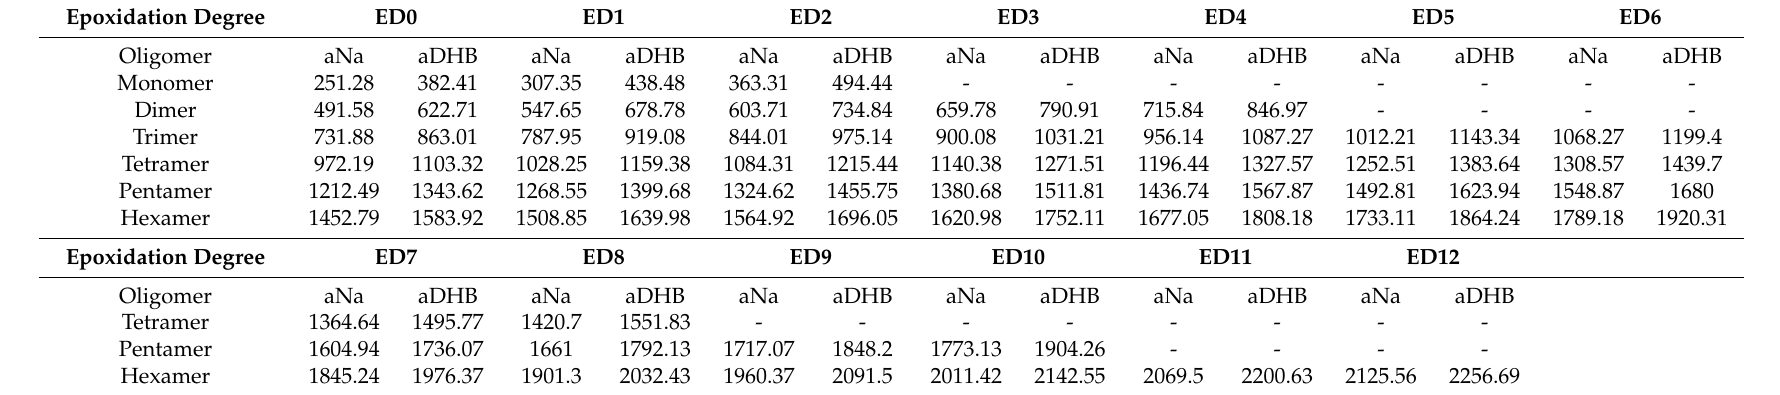
Table 2. Mass peaks as a function of the oligomer size versus adducts with sodium and